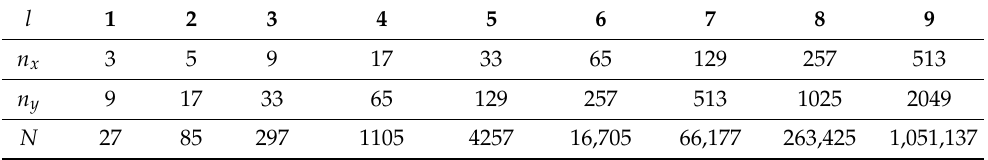
Table 2. Number of nodes at the grid level l